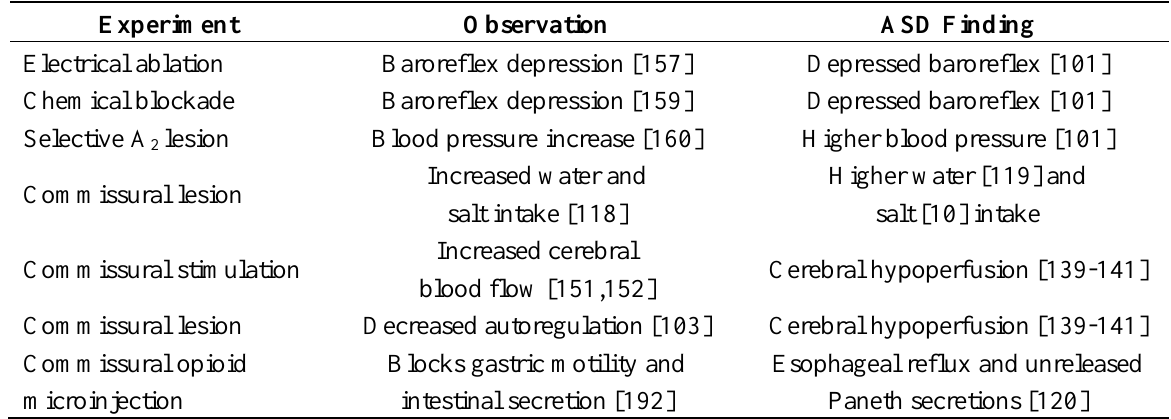
Table 2. NTS Animal Experiments and ASD